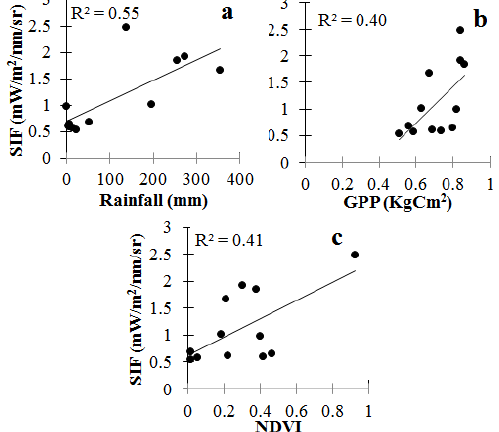
Figure 6. GOME-2 SIF relationship with rainfall (a), GPP (b) and NDVI (c) for TMD